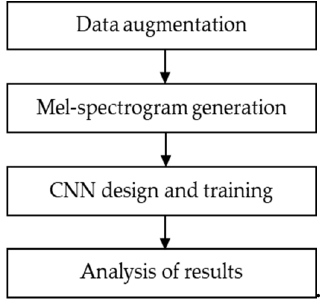
Figure 8. CPS topology. Physical system, DBR, Huelva, Spain; cyber system, ETSII, Sevilla, Spain.